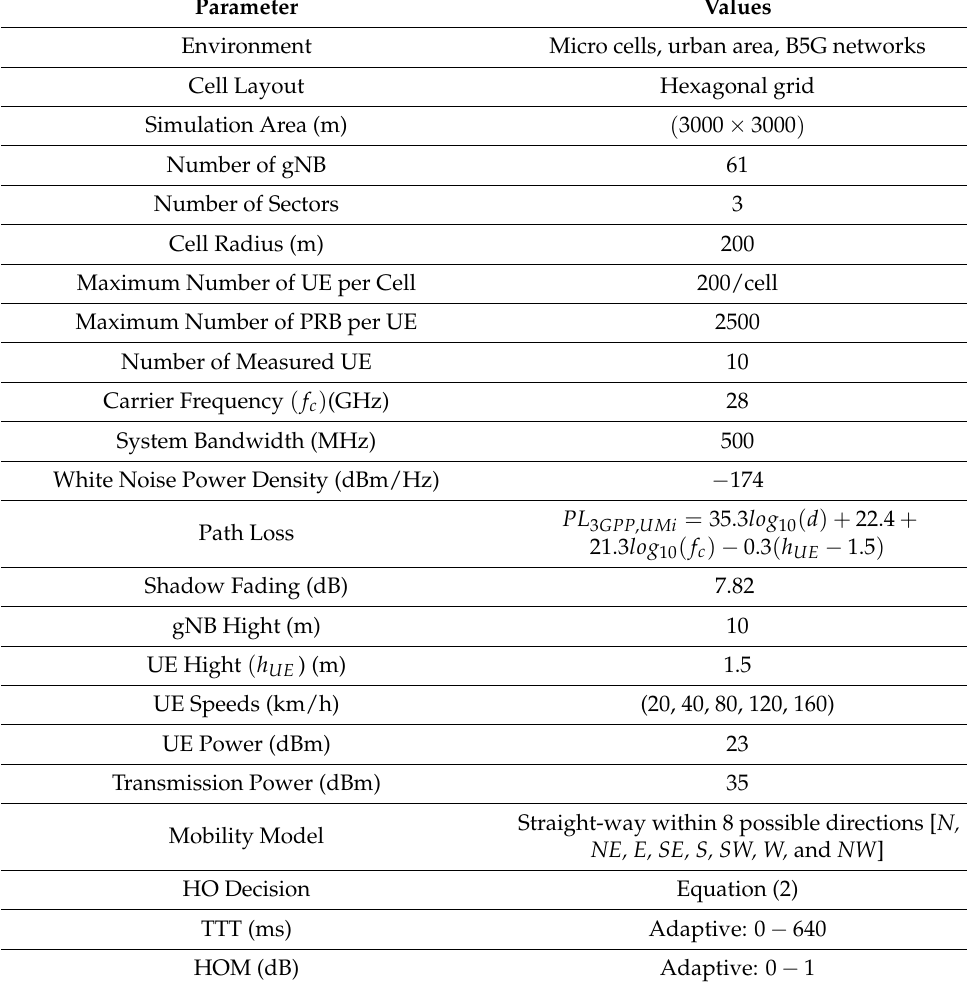
Table 3. Simulation parameters. Parameter